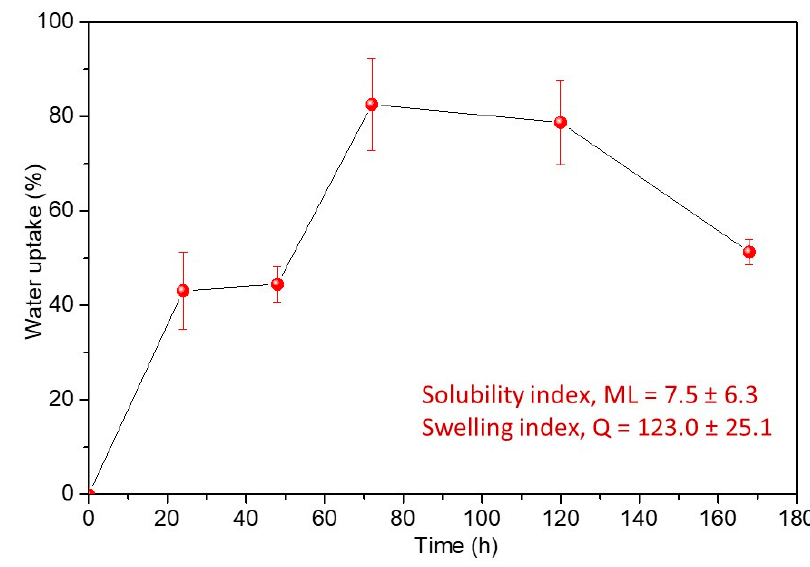
Figure 3. Water uptake of investigated PVA/TPS films over seven days.